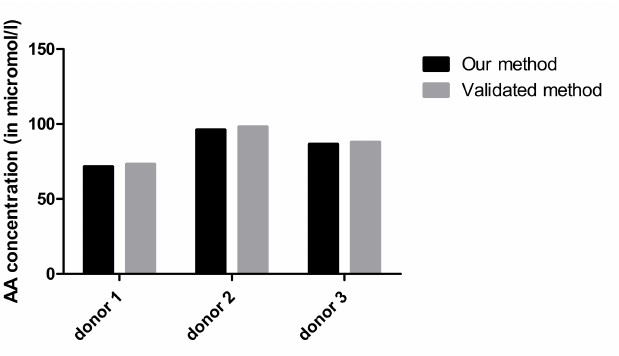
Figure 3. Comparison between plasma AA concentration with our method compared to the validated method.